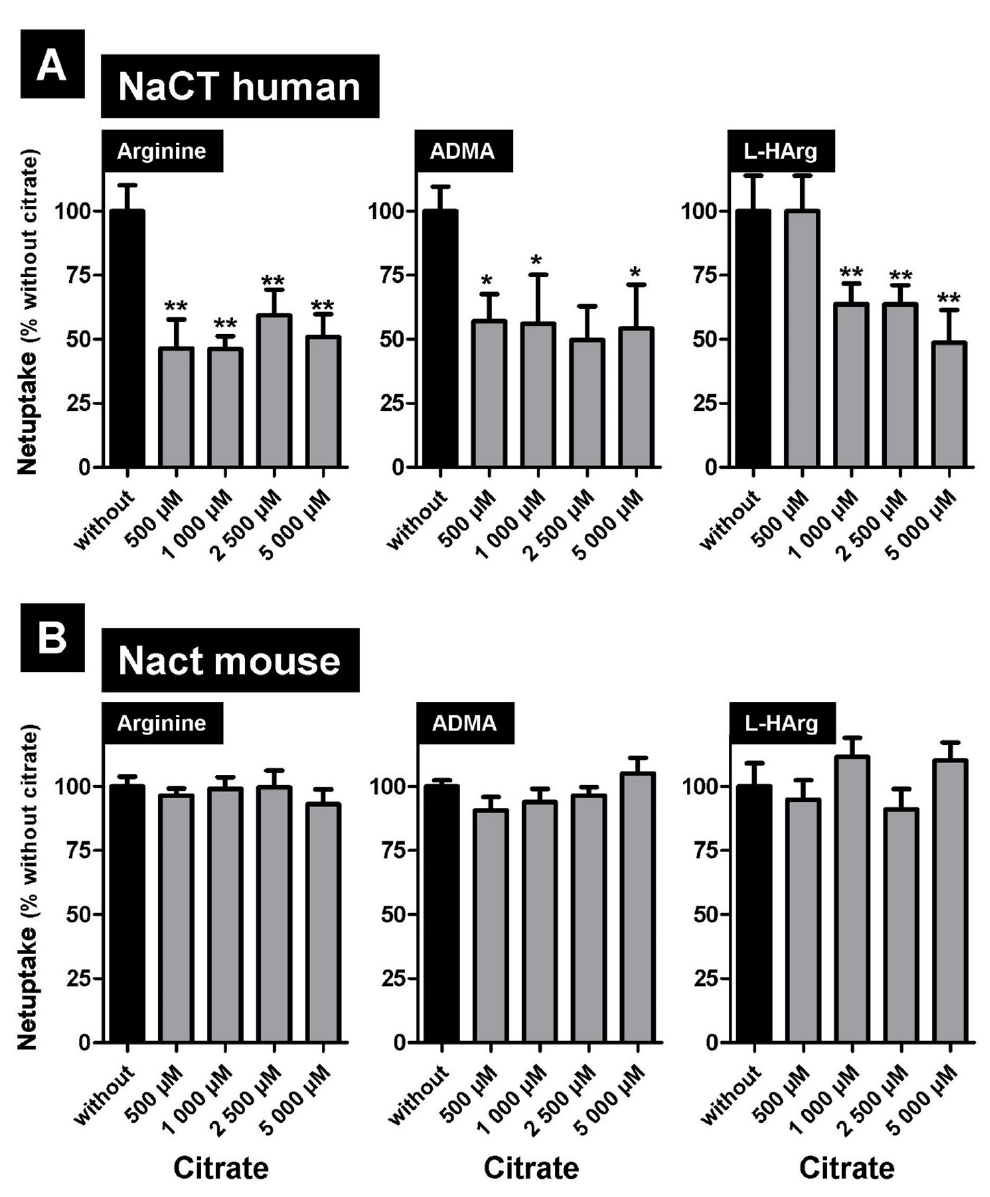
Figure 6. Inhibition of human ( A ) NaCT- and ( B ) mouse Nact-mediated arginine uptake of arginine (1 µM), asymmetric dimethylarginine (ADMA, 1 µM) and L-homoarginine (1 µM) by increasing concentrations of citrate. Net uptake without added citrate was set to 100% (black bars). * p < 0.01; ** p < 0.005 vs. uptake without added substance.